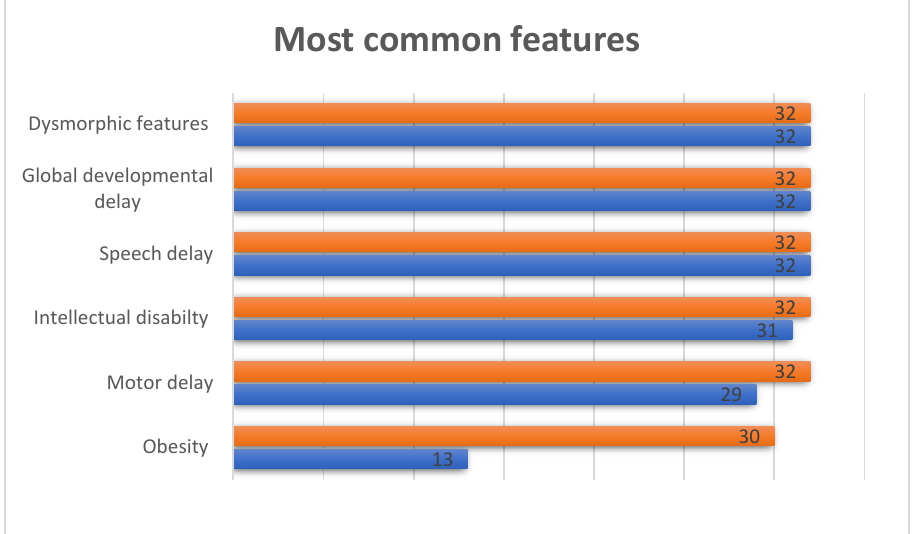
Figure 2. Most common features in individuals with TRIP12 variants. The orange bar shows the number of individuals in our cohort for whom phenotypic information was available and the blue bar shows how many individuals in our cohort scored positive on this particular clinical feature.